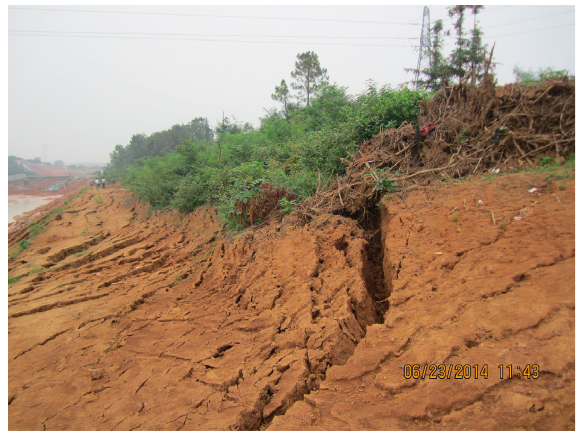
Figure 1: Site of the sample collected.